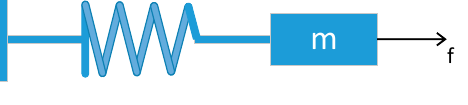
Figure 1. Mass-spring system.